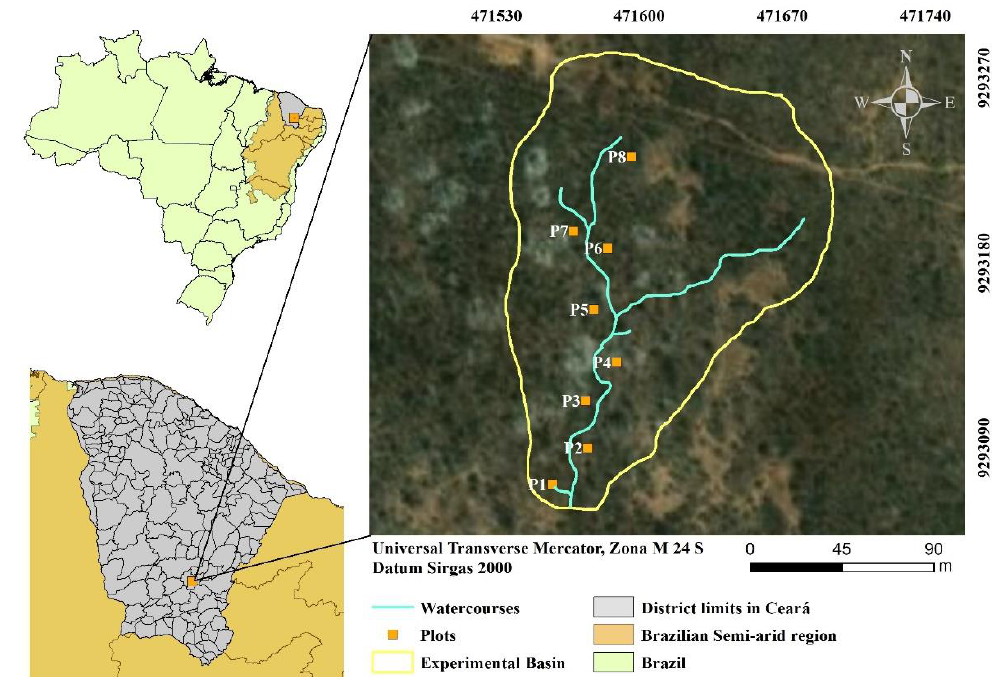
Figure 1. Location of the experimental area in the district of Iguatu, Ceará, Brazil.